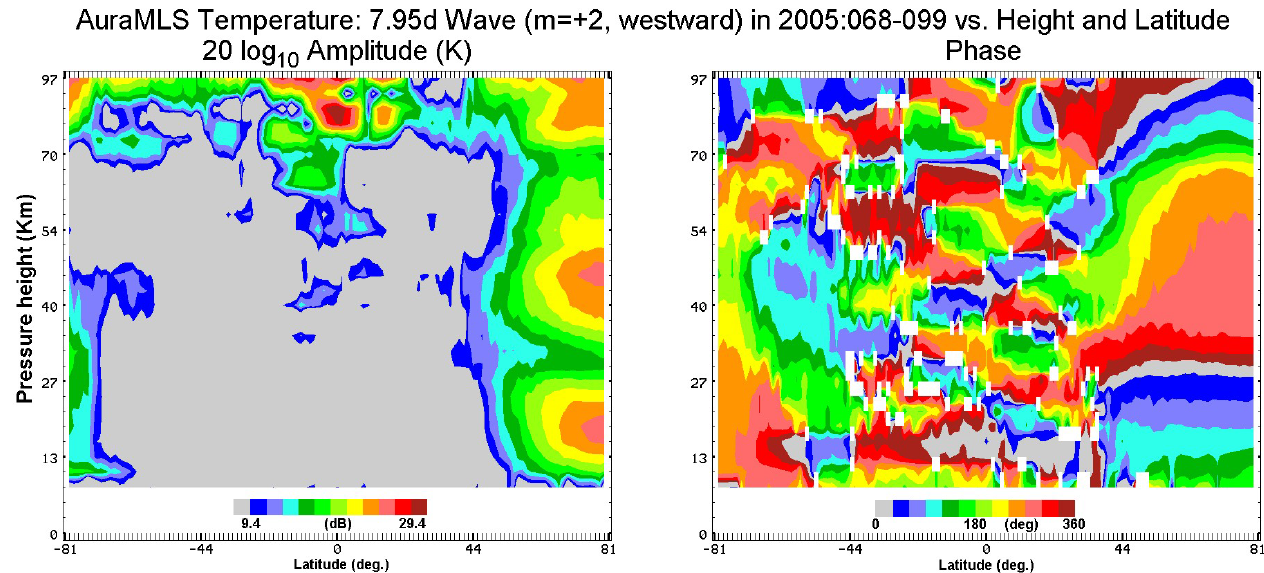
Fig. 4. Spring 2005 oscillation in temperature of period 7.95d, wave number +2: amplitude and phase values the Aura MLS. Data latitude range is: − 82S to